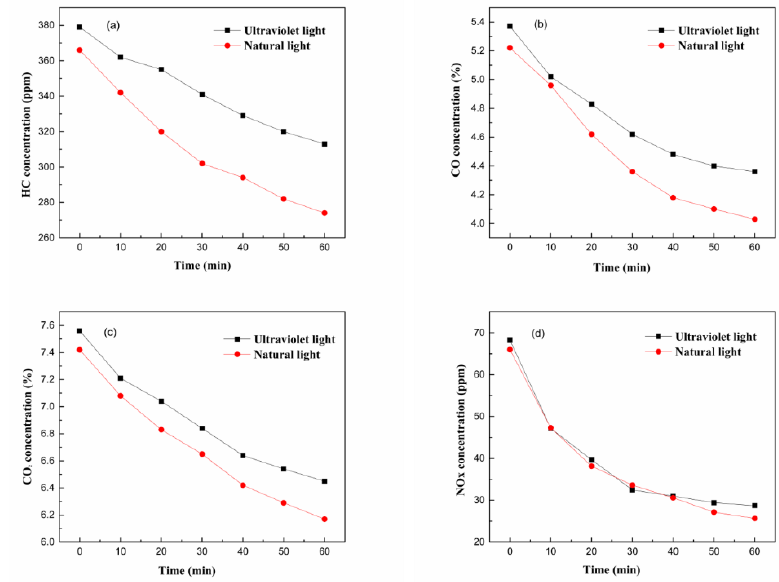
Figure 4. The change pattern of exhaust gas concentration ( a ) HC; ( b ) CO; ( c ) CO 2 ; and ( d ) NO X.